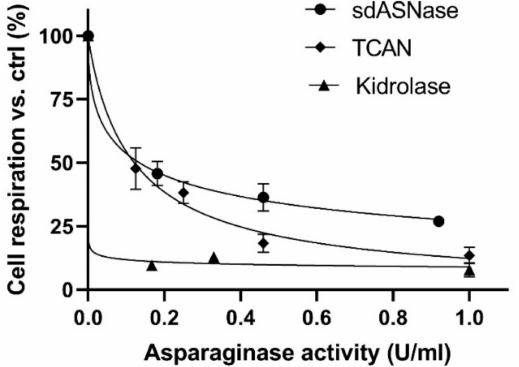
Figure 3. sdASNase, T-CAN and Kidrolase cytotoxicity on MOLT4 cells versus untreated control, expressed as a function of ASNase activity (U/mL) and evaluated by a cell respiration assay